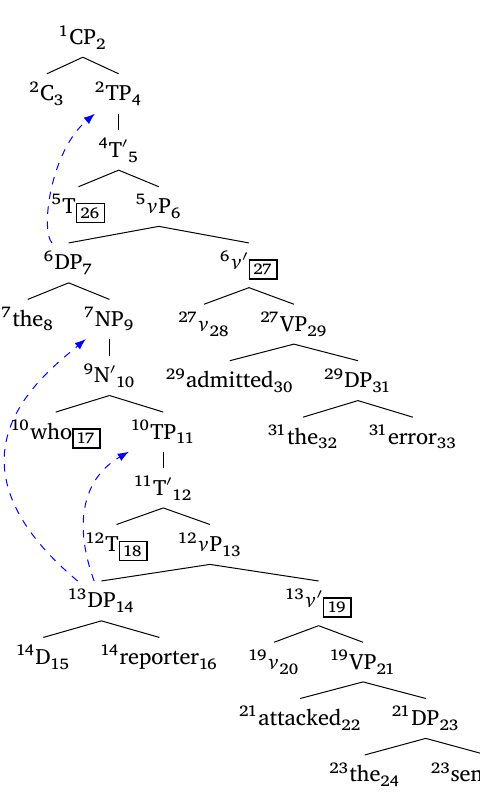
Figure 8: English SRC, promotion